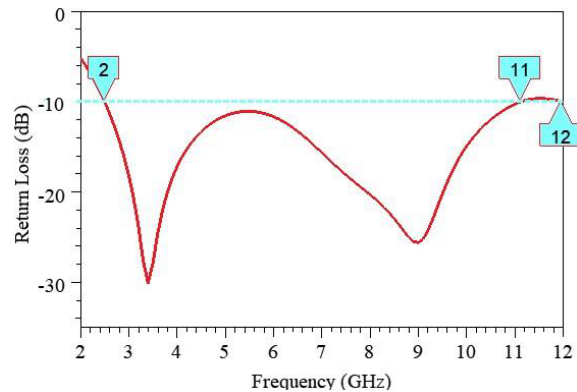
Fig. 4. Return loss verses Frequency of HMSA